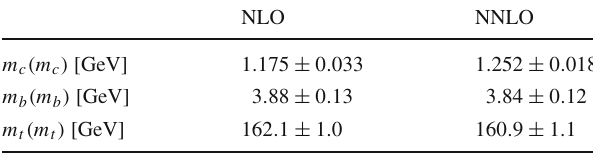
Table 3 The values of the c -, b - and t -quark masses in the MS scheme inunitsofGeVobtainedintheNLOandNNLOvariantsoftheABMP16 fi. The quoted errors reflect the uncertainties in the analyzed